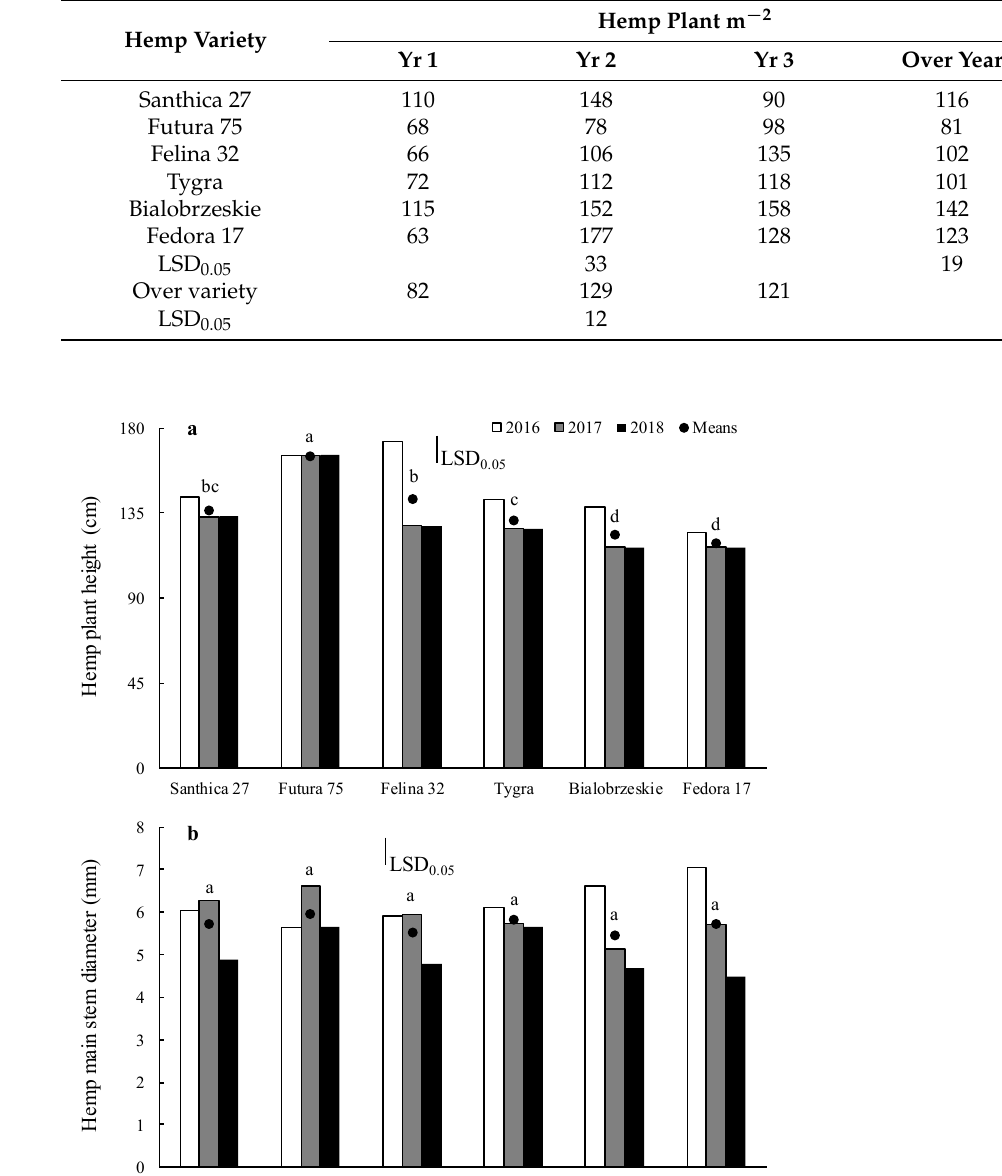
Table 1. Hemp plant density (plants m − 2 ) at 4 weeks after seeding of six industrial hemp varieties.